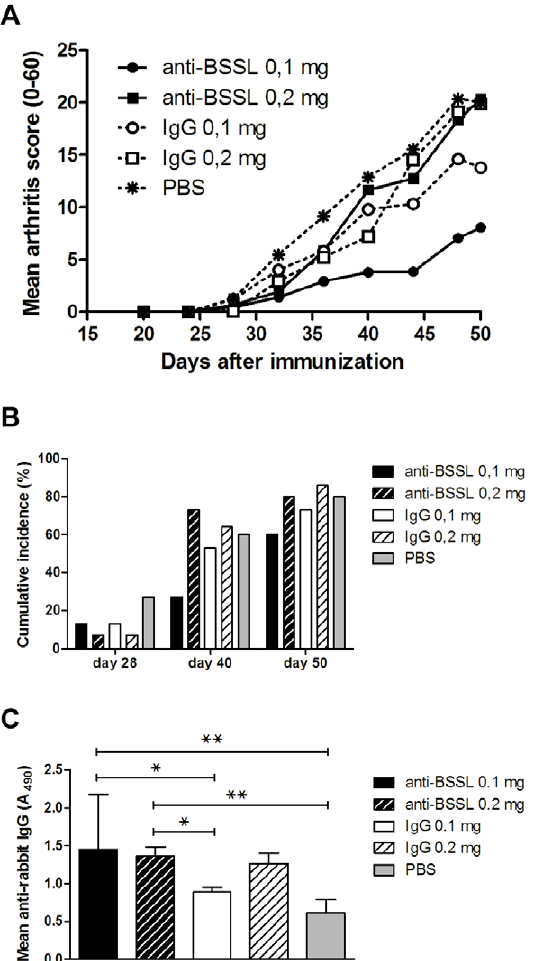
Figure 5. Inhibition of collagen-induced arthritis in DBA/1 mice by treatment with BSSL neutralizing antibodies. Seventy-five DBA/1 female mice were immunized with chick CII in CFA on day 0 and boosted with CII in IFA at day 21. Mice were randomized to one of five groups of 15 animals each, which, beginning on day 20, were treated every fourth day until day 44 with one of the following: 0.1 mg CDV15 antibody, 0.2 mg CDV15 antibody, 0.1 mg normal rabbit IgG, 0.2 mg normal rabbit IgG, or PBS (placebo control). Arthritis development and severity was followed by clinical scoring 2–3 times per week for 50 days after initial CII injection. (A) Mean score of arthritis severity and (B) cumulative incidence of arthritis (percentage of affected mice with clinical score $ 1) are shown. (C) At the time of discontinuation (day 50) the concentration of mouse anti-rabbit IgG was determined in plasma collected from all animals. Error bars indicate 6 SEM. For clarity, error bars were omitted in (A). ??? =p , 0.05; ??? =p , 0.01.